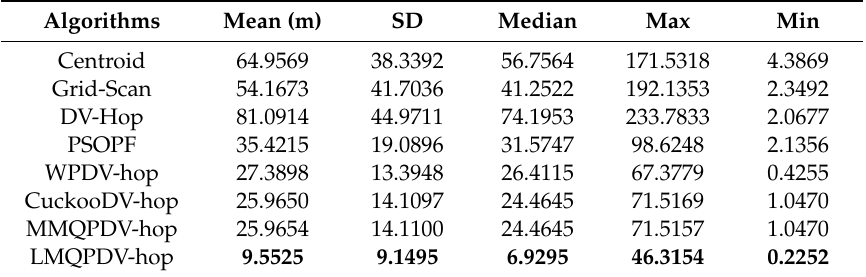
Table 5. Comparison results of location error WSN#1 through 10 independent runs.